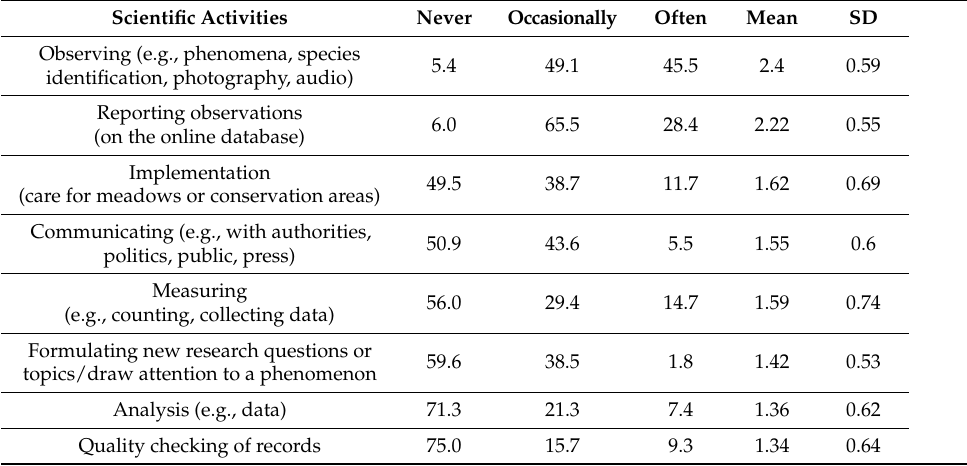
Table 1. Scientific activities of the citizen scientists 1